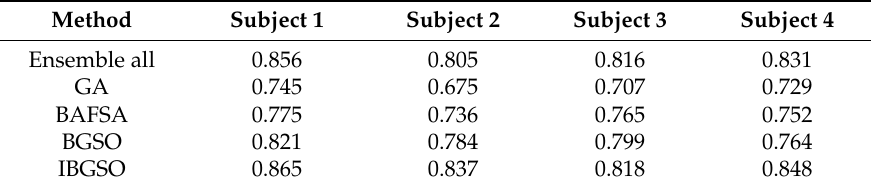
Table 12. F1 comparison of the four randomly selected subjects for the five approaches using the